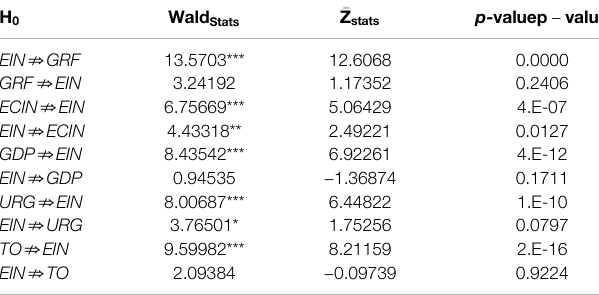
TABLE 10 | Dumitrescu – Hurlin panel